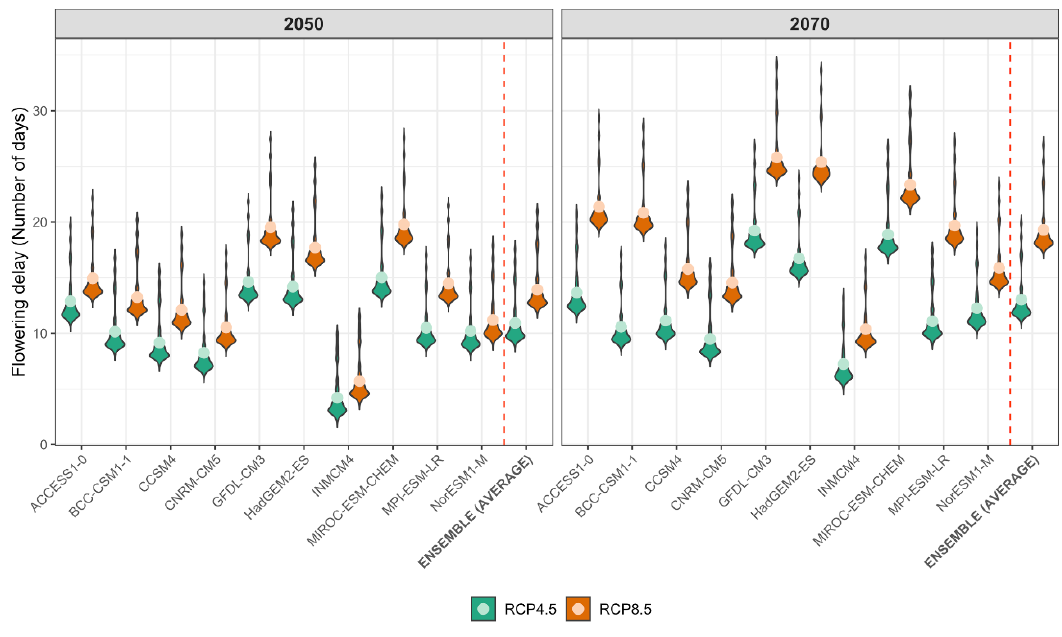
Figure 7. Potential phenological changes applying the logarithmic forecasting models based on the future climatic conditions projected by multiple General Circulation Models for RCPs 4.5. and 8.5. Points reflect the mean phenological changes for each GCM. The dashed red line indicate the Ensemble model calculated as average of the considered General Circulation Models.